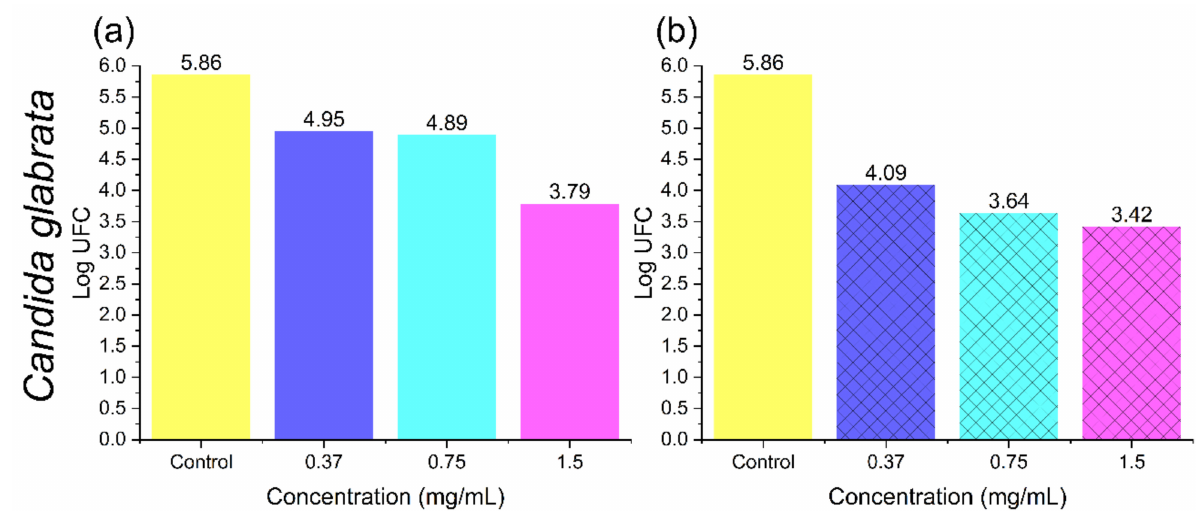
Figure 7. Antifungal activity on Candida glabrata of ( a ) coffee husk, and ( b ) AgNPs–coffee husk.